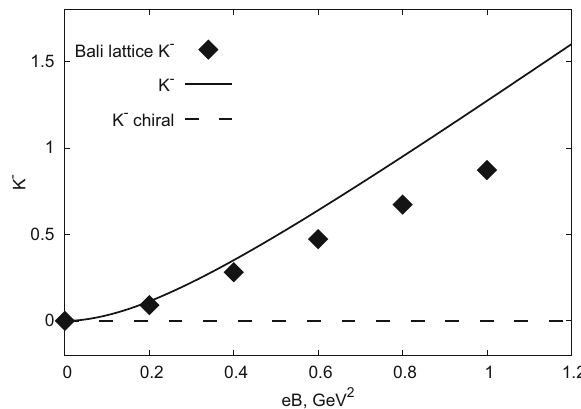
Fig. 2 The K + ( eB calculated with ECL (solid line) in comparison with the lattice data from [25] and chiral perturbation theory (dashed line)